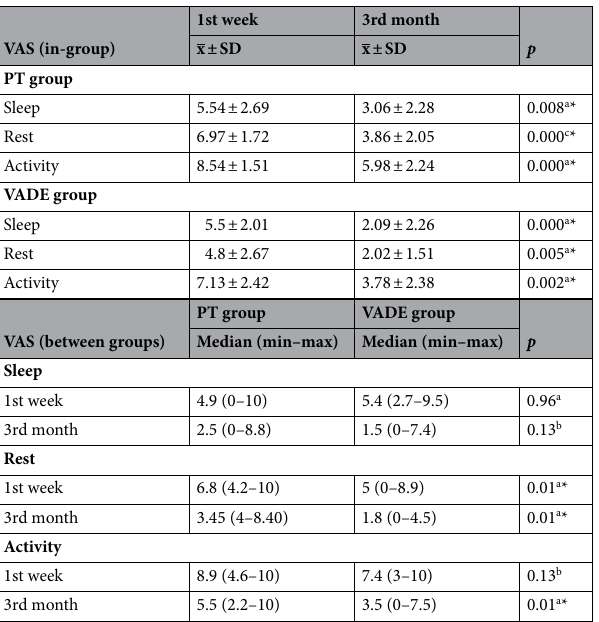
Table 2. Comparison of pain levels of patients. PT physiotherapy, VAS visual analog scale, VADE video- assisted discharge education, min minimum, max maximum, * p < 0.05 statistically significant difference, x